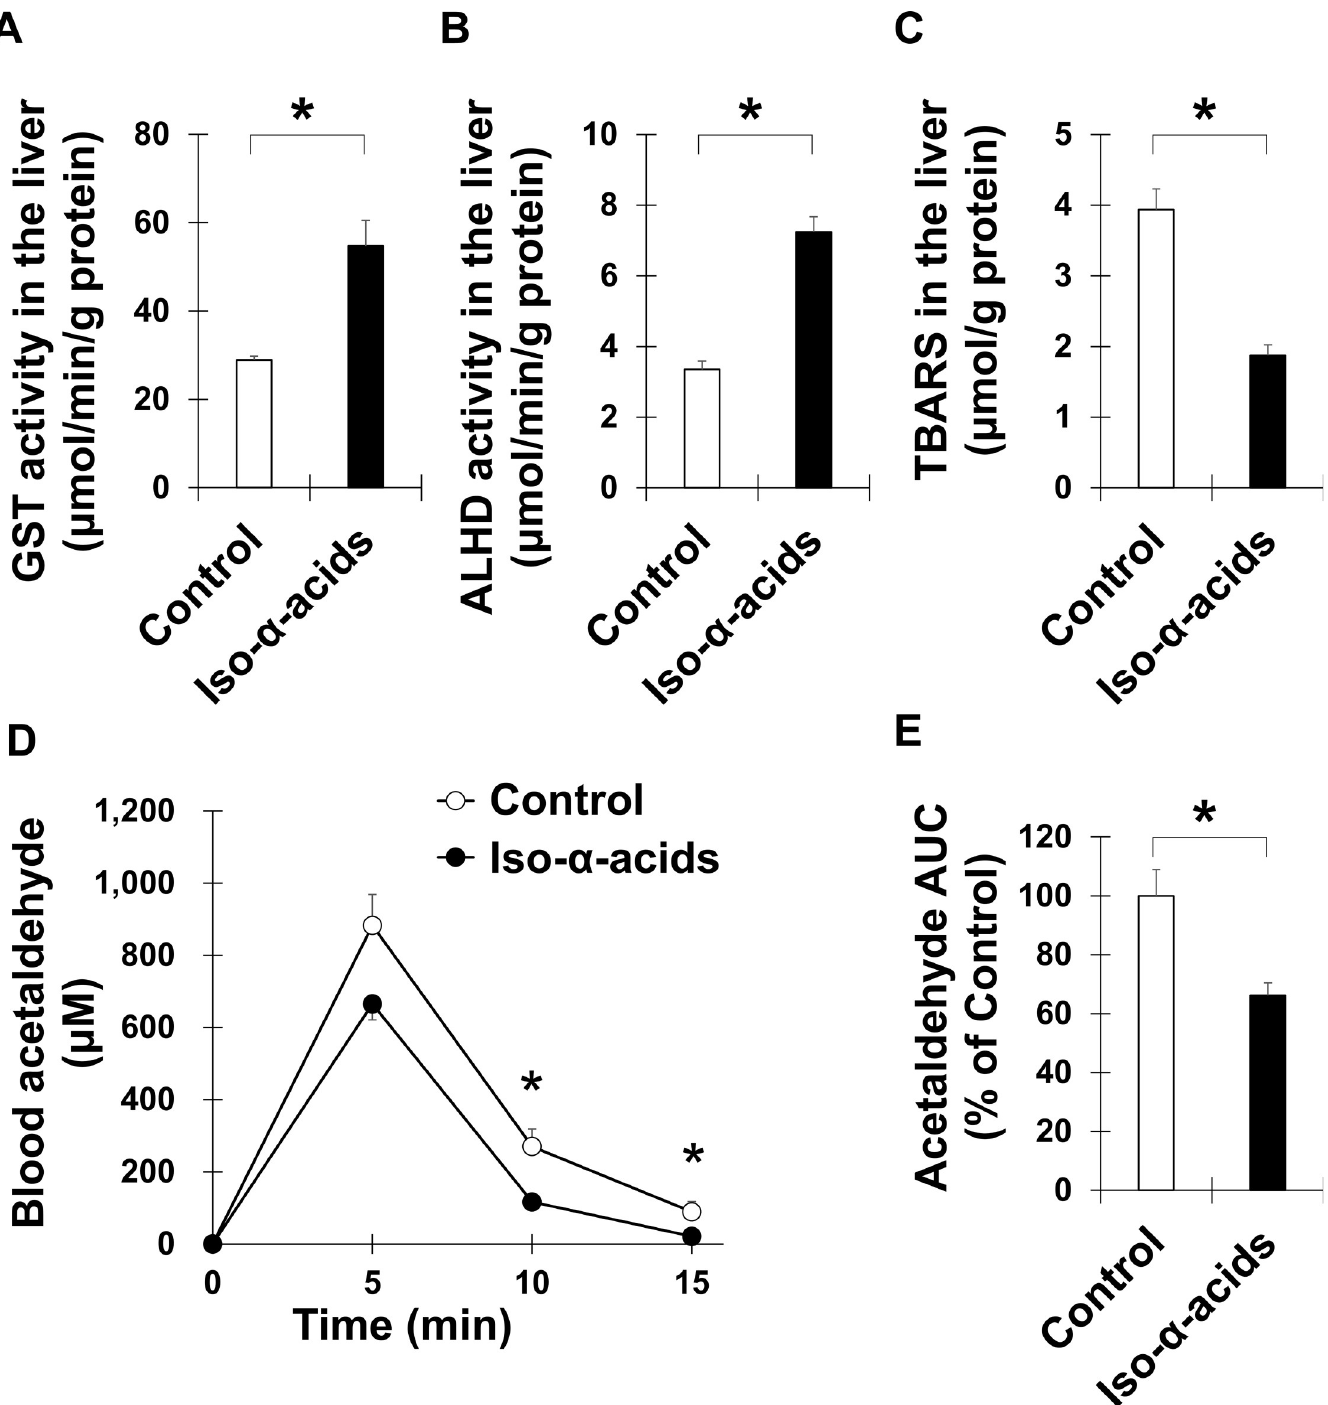
Fig 3. The effect of iso- α -acids on hepatic GST activity, ALDH activity, oxidative stress and blood acetaldehyde metabolism. Mice fed the control diet or the iso- α - acids diet for a week were treated with acetaldehyde (200 mg/kg, i.p.). The GST activity (A), ALDH activity (B) and TBARS (C) levels of the liver tissues 5 hours after the treatment were examined ( n = 10). (D) Time course of the acetaldehyde concentrations of the blood samples after acetaldehyde treatment were examined ( n = 5). (E) Areas under the curve were calculated by trapezoidal rule from 0 to 15 min. Data are represented as the mean ± S.E.M. � p < 0.05 (vs. the control group).